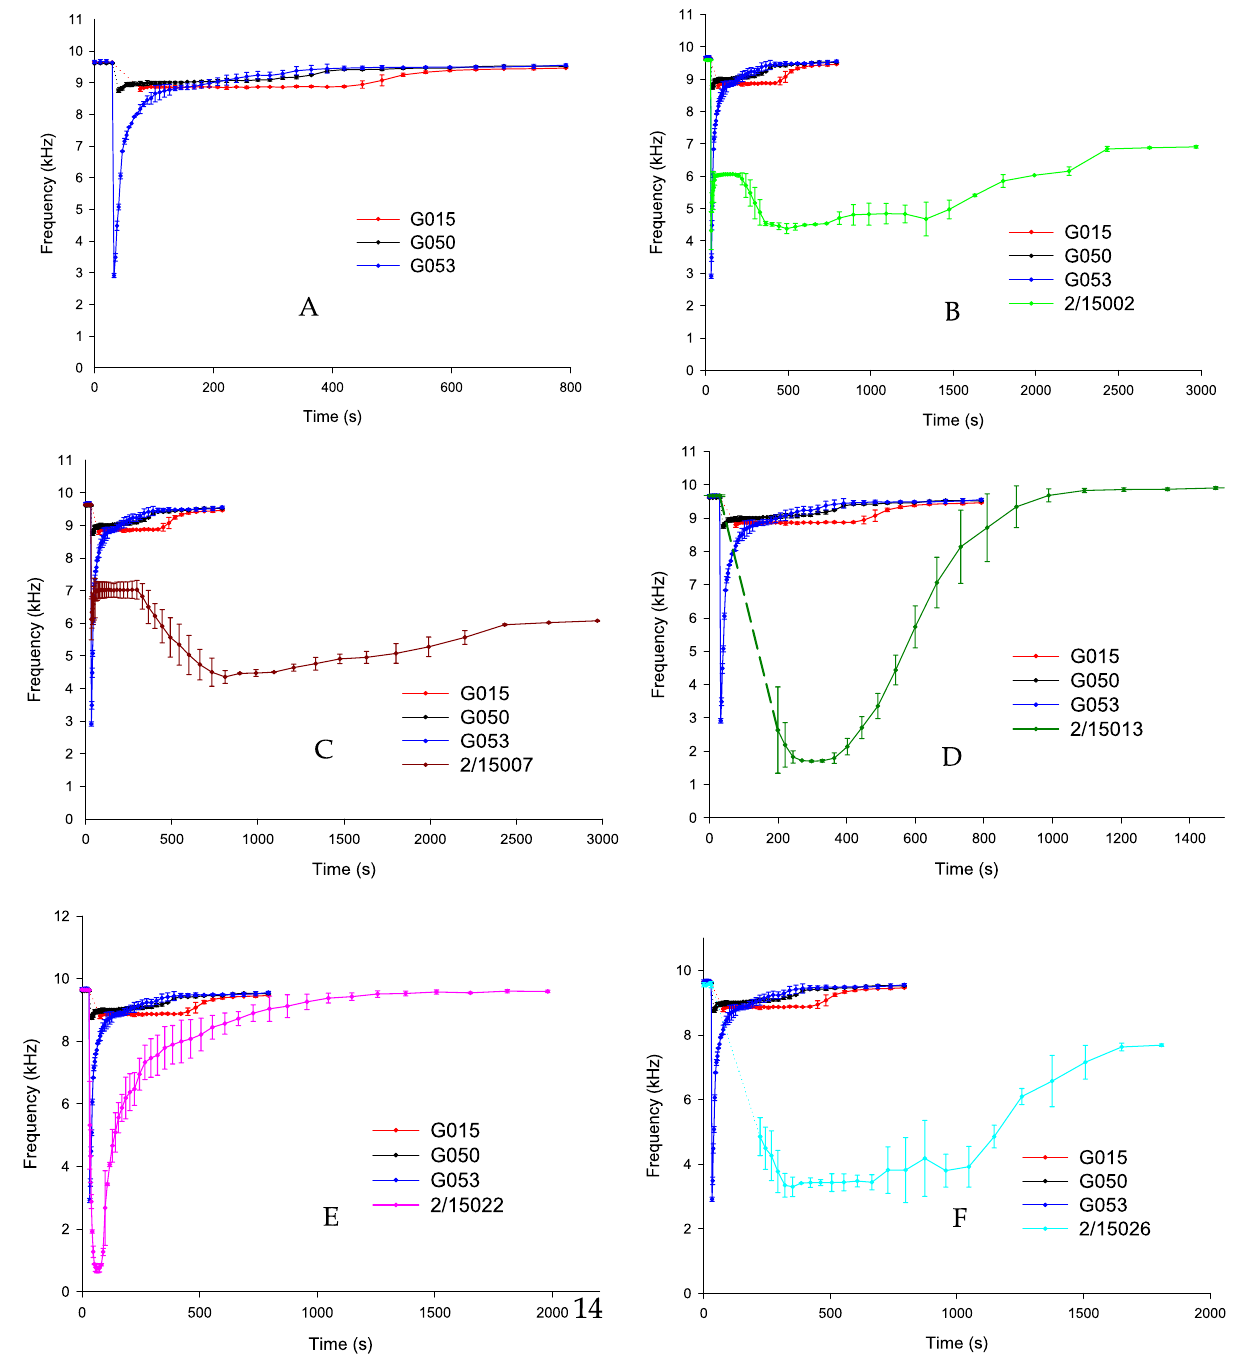
Figure 7. ( A ) BARDS profiles of three batches of genuine artesunate tablets manufactured on different dates, dissolved in 25 ml of 0.10 M HCl. ( B ) BARDS Analysis of falsified (2/15002) and genuine artesunate tablets (G015, G050, G053) dissolved in 25 ml 0.1 M HCl. ( C ) Comparison of falsified artesunate tablets (2/15007) and genuine artesunate tablets (G015, G050, G053) dissolved in 25 ml of 0.10 M HCl. ( D ) Comparison BARDS profiles of falsified artesunate 2/15013 and genuine (G015, G050, G053) artesunate tablets. ( E ) BARDS analysis of falsified (2/15022) and genuine (G015, G050, G053) artesunate tablets dissolved in 25 ml 0.1 M HCl solvent. ( F ) BARDS data of falsified (2/15026) and genuine (G015, G050, G053) artesunate tablets dissolved on 25 ml 0.1 M